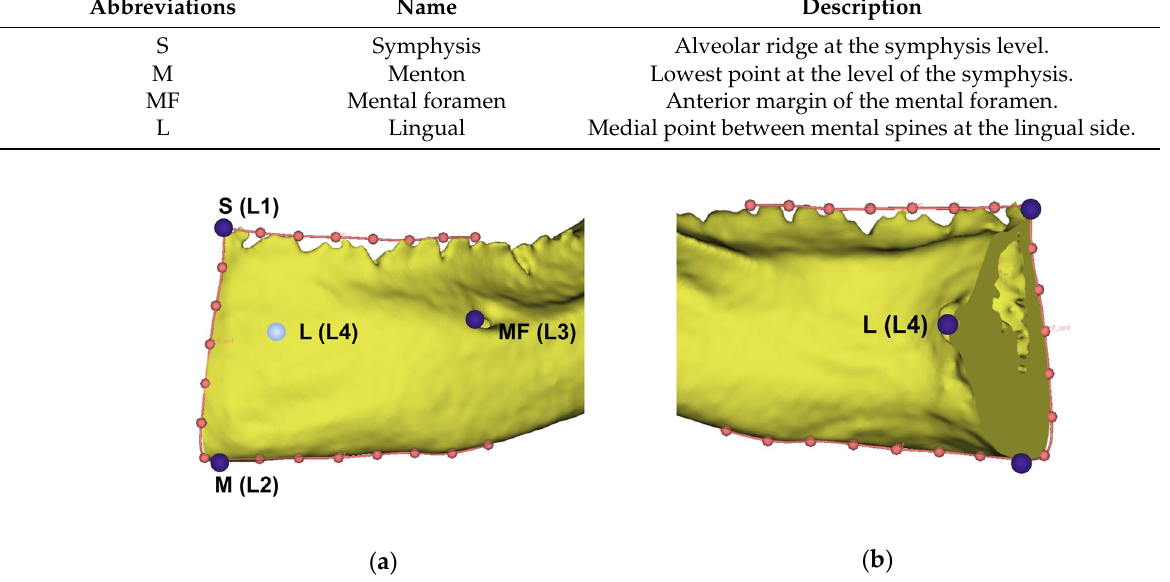
Figure 2. Three-dimensional landmarks and curves digitized on the interforaminal hemimandibular region. ( a ) Buccal view; ( b ) lingual view.